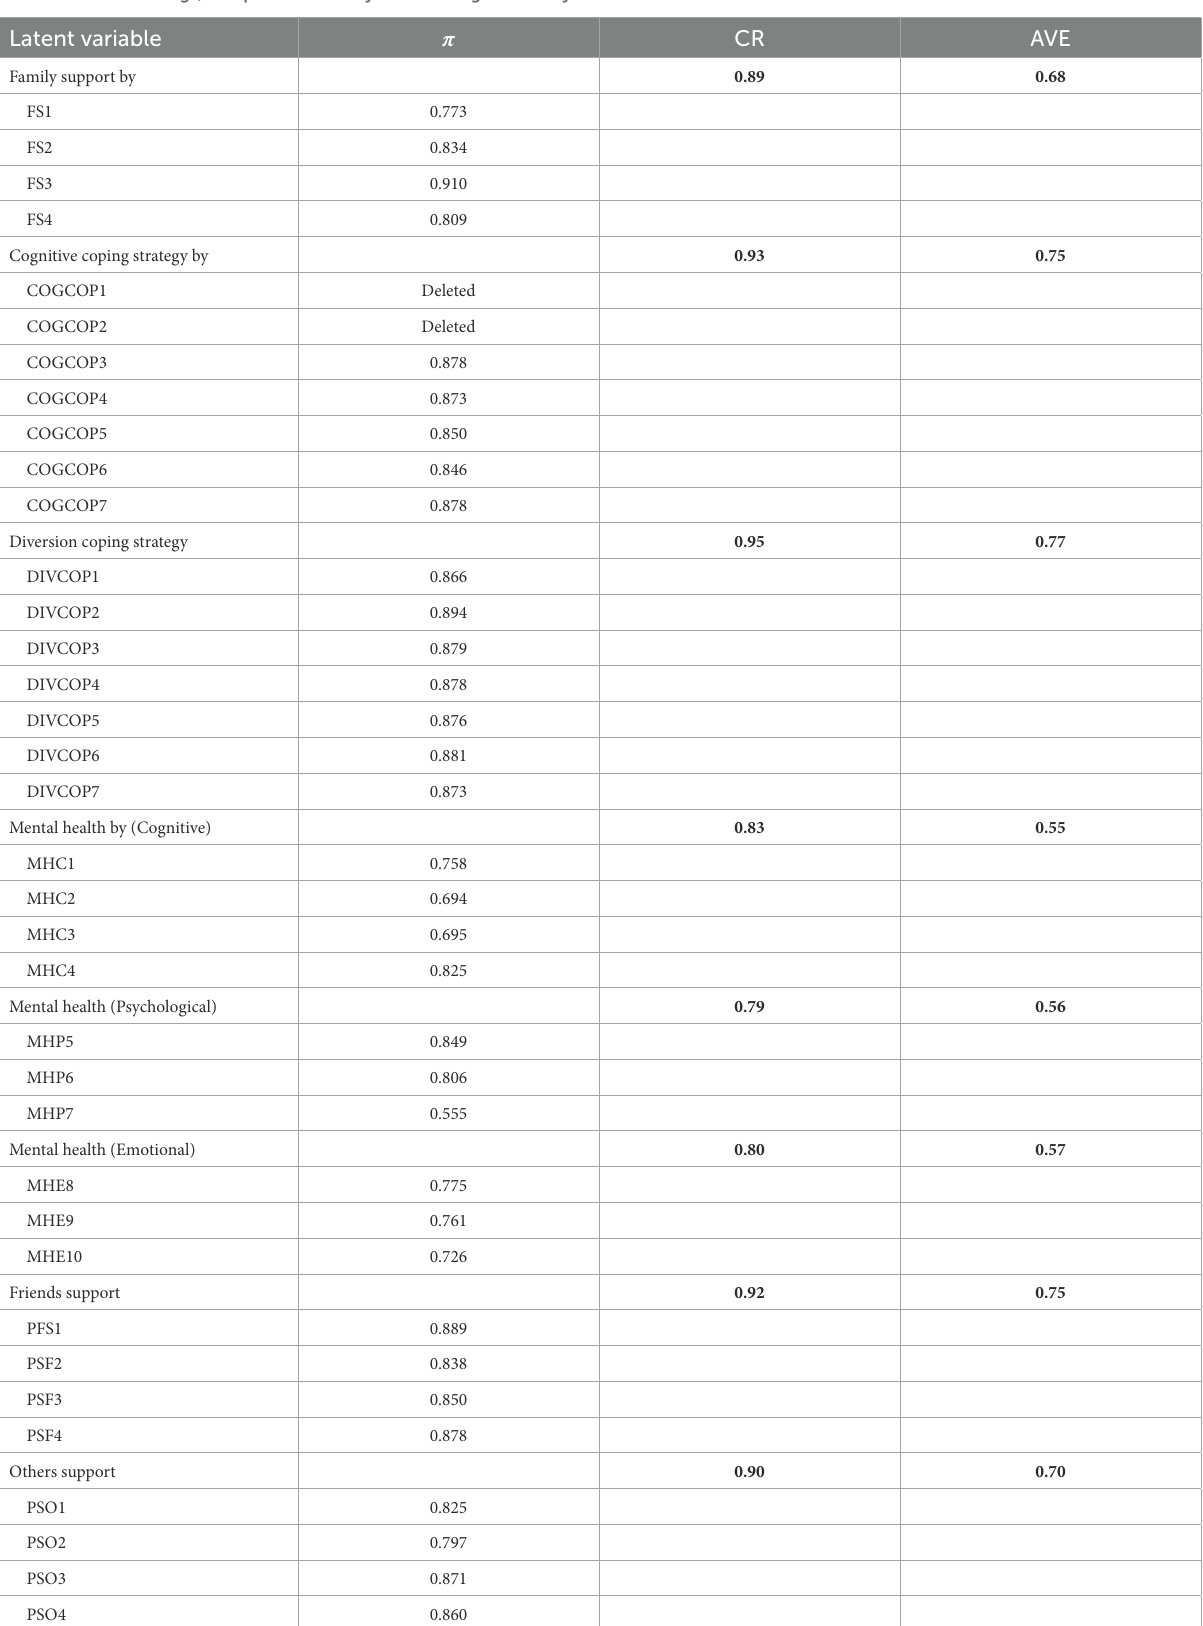
TABLE 2 Factor loadings, composite reliability and convergent